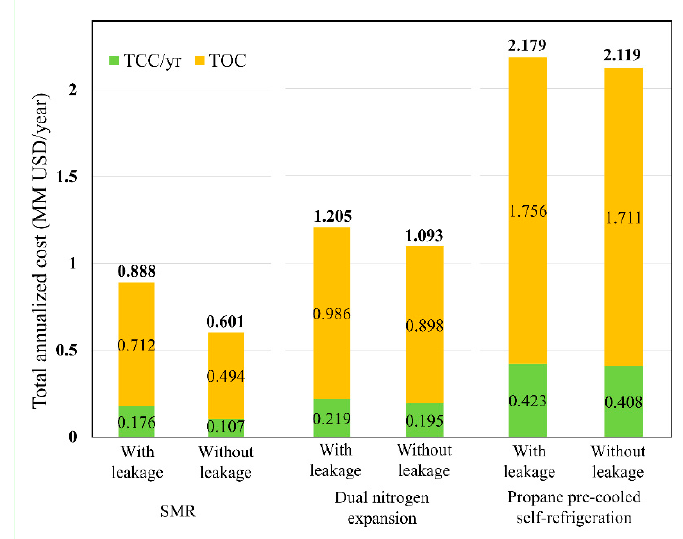
Figure 9. TAC comparison of the base case with/without the makeup system.